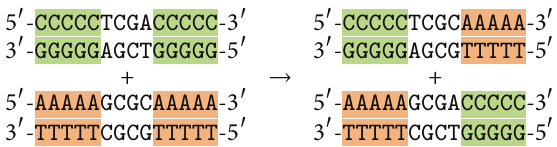
Figure 2: The operation of